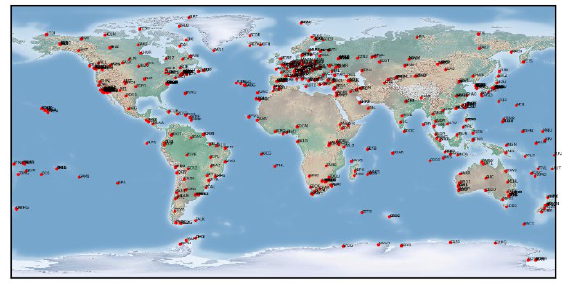
Figure 1. Distribution of IGS network (IGS, 2022b) Different analysis centres uses slightly different models, software, strategy and station selection that involved in ephemerides generation (IGS, 2020). The products from different analysis centres are then combined using interactive weighting to form the IGS ephemerides (Urs Hugentobler, 2017). Not all stations in the IGS network are involved in the ephemeris generation. Figure 2 shows an example of the station selected processed by Centre for Orbit Determination in Europe (CODE) on 23 rd August 2019. Red squares are stations coordinates estimated with constraints while yellow circle are stations coordinates estimated without constraints. Processed station by CODE on